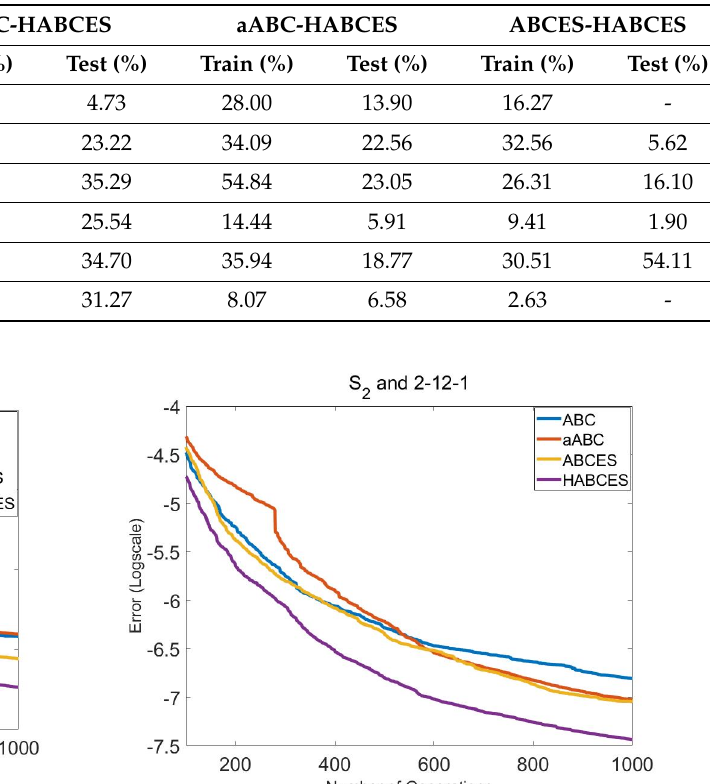
Table 8. Performance increase achieved when using HABCES for nonlinear static system identification.